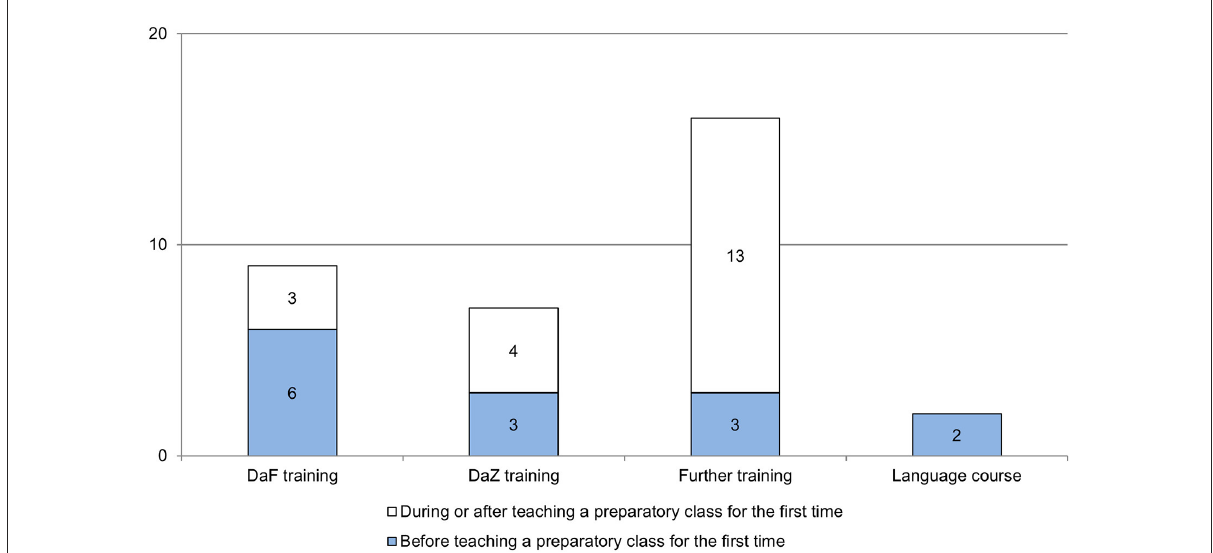
FIGURE1 Target group-specific professional training according to time of completion (absolute frequencies; multiple answers possible; source: survey of teachers in preparation classes, n =